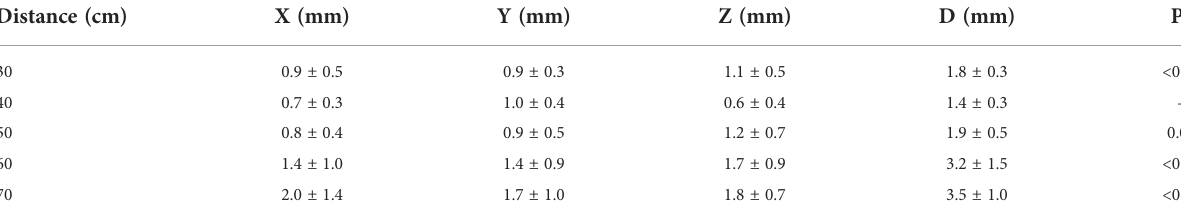
Statistical signi fi cance P 3 : 40 cm vs. other tracking